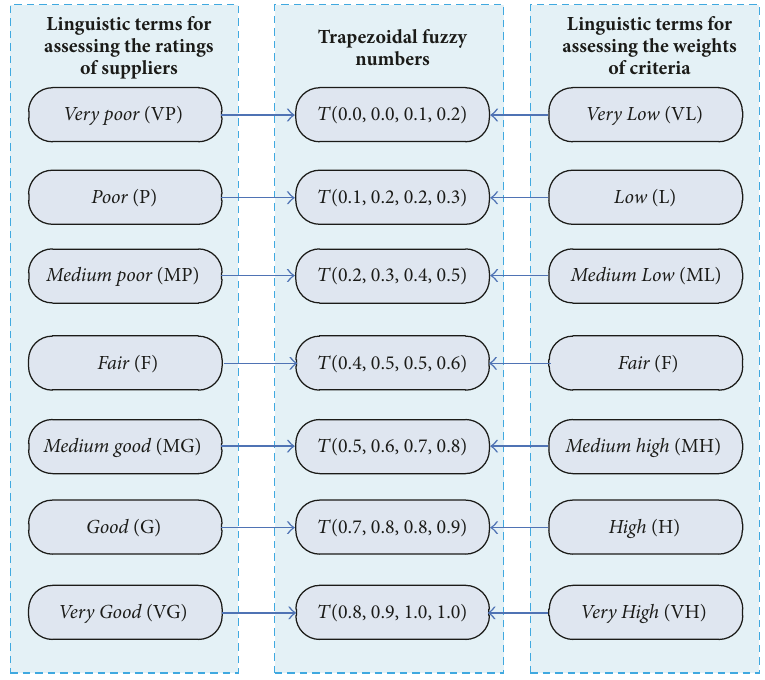
Figure 1: A seven-point rating scale-based linguistic rating system based on TrFNs.